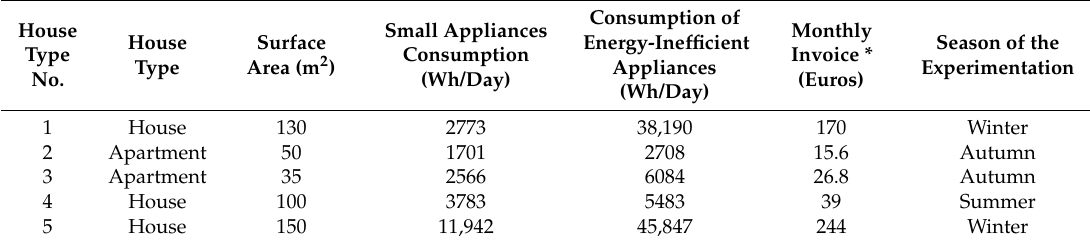
Table 1. Main features of the reference